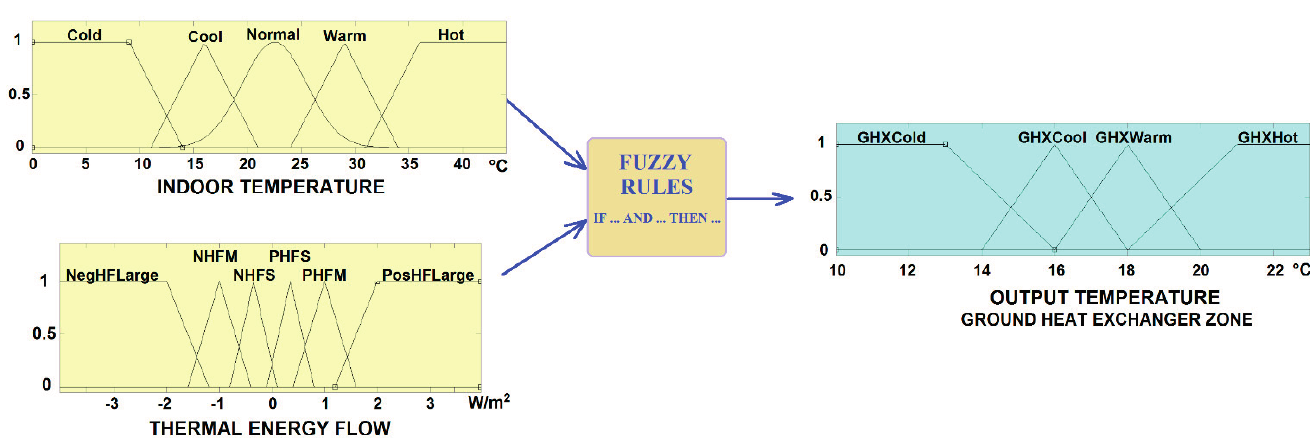
Figure 15. Fuzzy controller for the selection of the thermal energy source